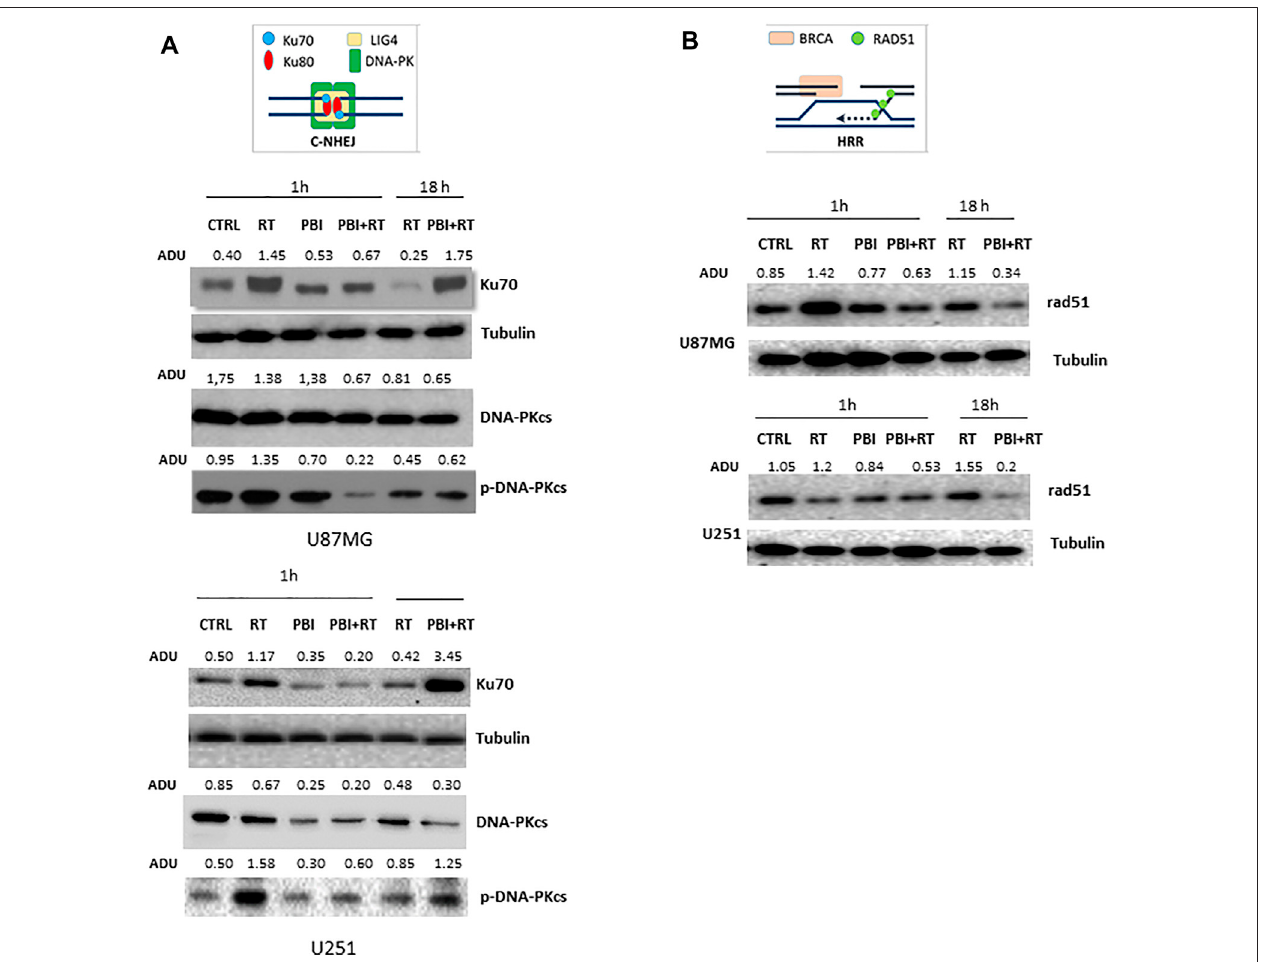
FIGURE5| ExpressionofDNAdamagerepairproteinsinU87MGandU251cells. (A) WesternblotsofKu70,DNA-PKcsandp-DNA-PKcsproteinsinU87MGand U251 cells following treatment with RT (4 Gy), PBI-05204 (2.5 μ g/ml) or a combination of RT and PBI-05204. The relative abundance of Ku70 and DNA-PKcs proteins was calculated based on the levels of α -tubulin whereas the level of p-DNA-PKcs protein was normalized by DNA-PKcs. (B) representative Western blots of Rad51 in U87MG and U251 cells after treatment with RT (4 Gy), PBI-05204 (2.5 μ g/ml) or a combination of RT and PBI-05204.